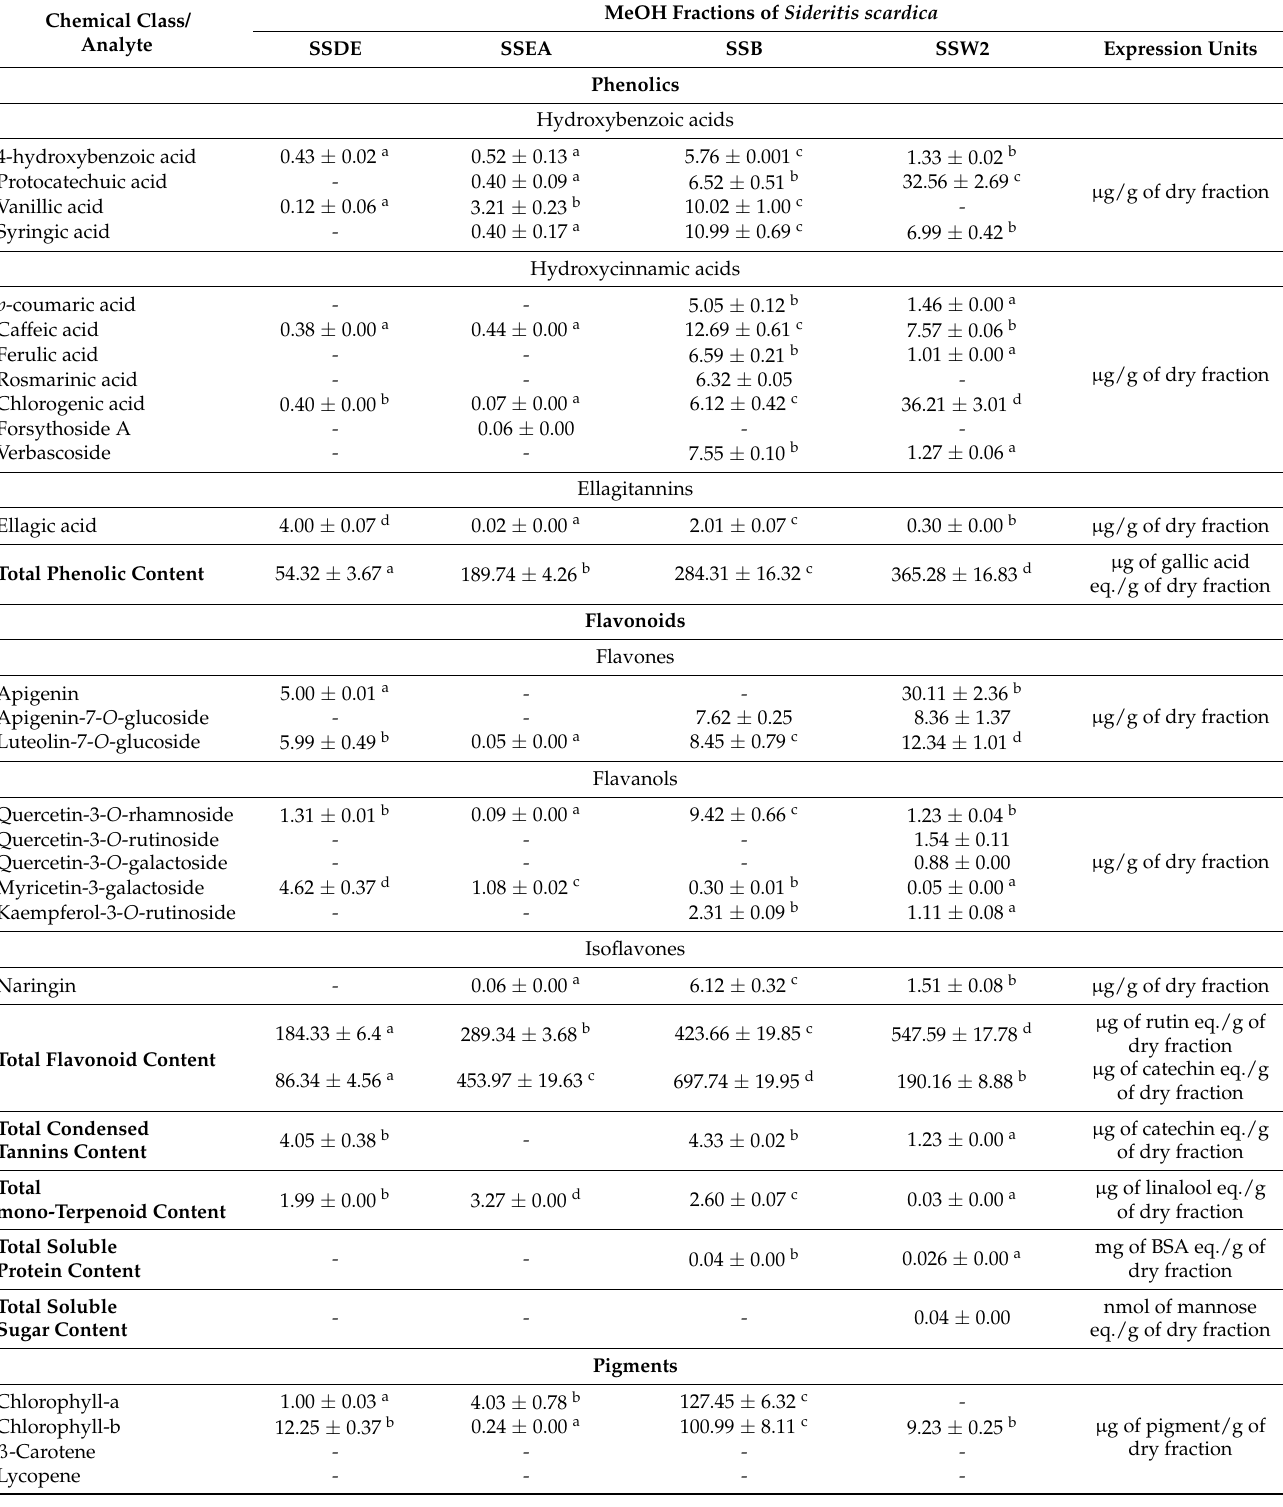
Table 2. Quantitative information illustrating the phytochemical contents of the four isolated (diethyl ether—SSDE; ethyl acetate—SSEA; butanol (organic phase)—SSB; butanol (aqueous phase)—SSW2) fractions of methanolic extract (SSM) of S. Scardica. The results represent the means ± SD of six sepa- rate studies. Tukey’s test ( p < 0.05) showed that means and SDs proceeded by different letters in the same row importantly vary from one